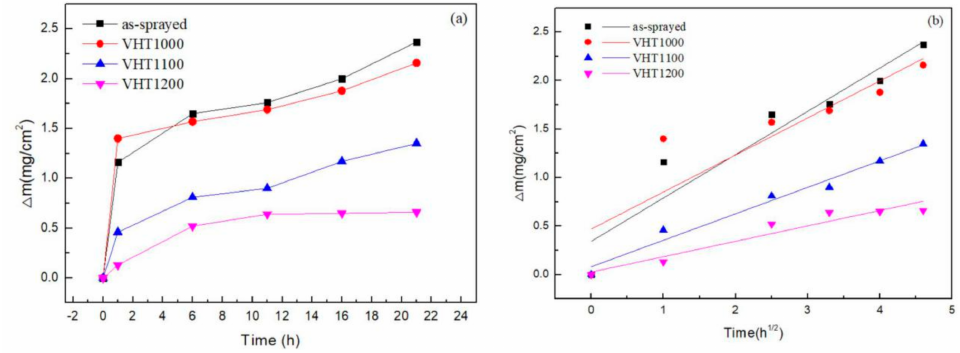
Figure 5. Weight gain data of the as-sprayed coating and VHT coatings after 21 h oxidation ( a ) original curve ( b ) fitting